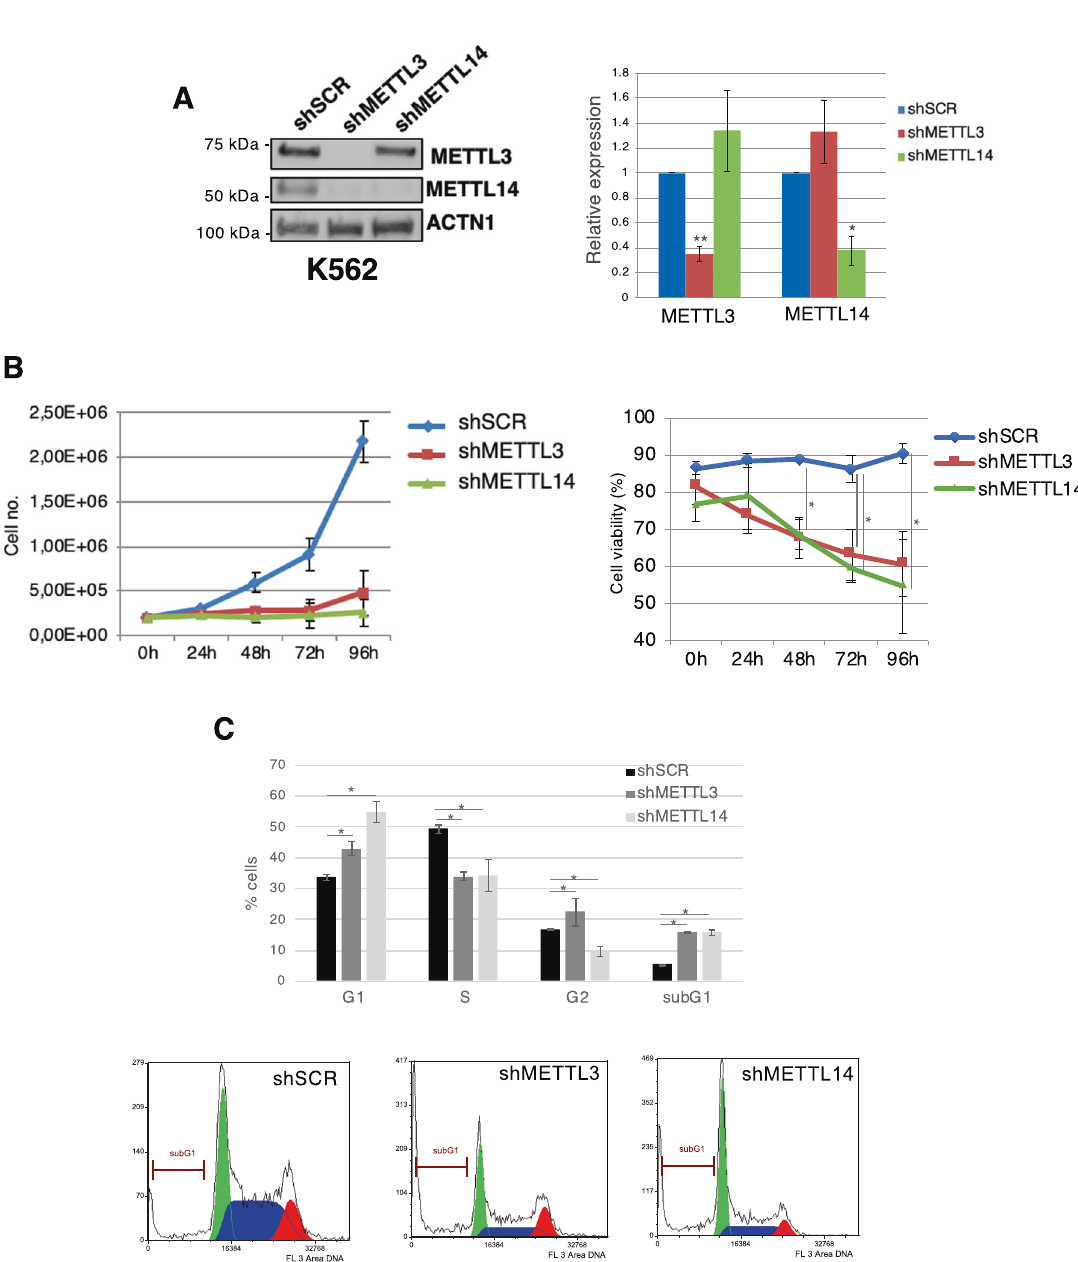
Fig. 2 METTL3 and METTL14 knockdown affects K562 cells proliferation. A Left panel: Western blot analysis of METTL3 and METTL14 levels in shMETTL3, shMETTL14 and shSCR K562 transduced cells. Protein levels were analyzed 48 h after puromycin selection. Right panel: expression levels of METTL3 and METTL14 mRNA in shSCR, shMETTL3 and shMETTL14 cells. Values are normalized against ACTB and expressed as relative quantities with respect to shSCR cells set to a value of 1; n = 3. Relative RNA quantity in the bars is represented as the mean of the fold change with standard deviation. B Growth curve (left panel) and percentage of cell viability (right panel) of K562 infected cells after puromycin selection, n = 3. C Left panel, the histogram represents the cell cycle distribution of cells analyzed 48 h after puromycin selection, n = 3. Right panel, representative cell cycle analysis. The ratio of each sample versus its experimental control was tested by two- tailed Student ’ s t -test. * p < 0.05, ** p < 0.01.